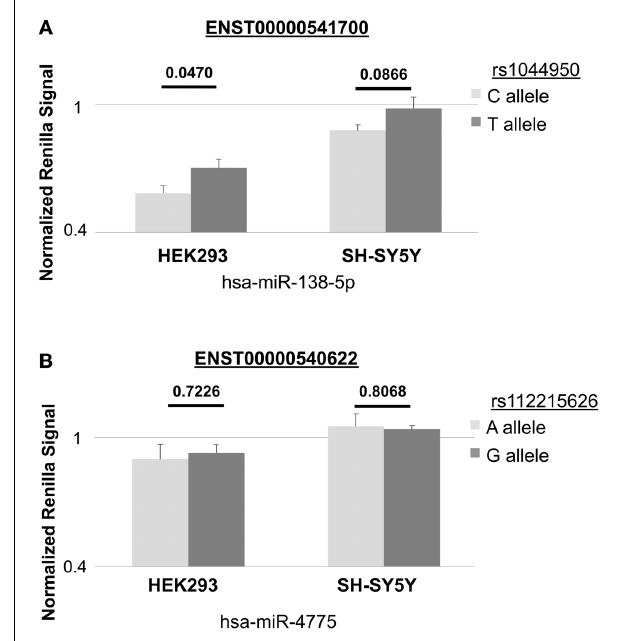
FIGURE 2 | In vitro effects of rs1044950 and rs112215262 on miRNA-to-mRNA binding and gene expression. The bar charts show the normalized Renilla luciferase expression in constructs containing DCP1B 3 (cid:2) UTR and corresponding SNP alleles. Depicted are the mean Renilla luciferase intensities and the standard errors relative to the control luciferase intensities of the construct co-transfected with the non-targeting miRNA control (corresponding to the horizontal line): (A) for transcript ENST00000541700 containing the reference (G) or alternative (A) allele of rs1044950 and co-transfected with has-miR-138-5p into HEK293 and SH-SY5Y cells. The relative mean luciferase luminescence of the construct containing the G and the A allele was 0.585 ( ± 0.0335) and 0.703 ( ± 0.0417) in HEK293 cells, and 0.880 ( ± 0.0256) and 0.985 ( ± 0.0513) in SH-SY5Y cells. (B) for transcript ENST00000540622 containing the reference (T) or alternative (C) allele of rs112215626 and co-transfected with